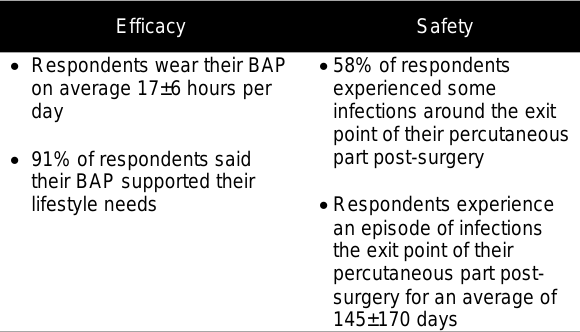
Table 2: Key figures about the efficacy and safety of surgical implantation of the osseointegrated fixation and fitting with bone- anchored prosthesis (BAP) extracted from self-reported ad hoc consumers survey administered by Queensland Artificial Limb